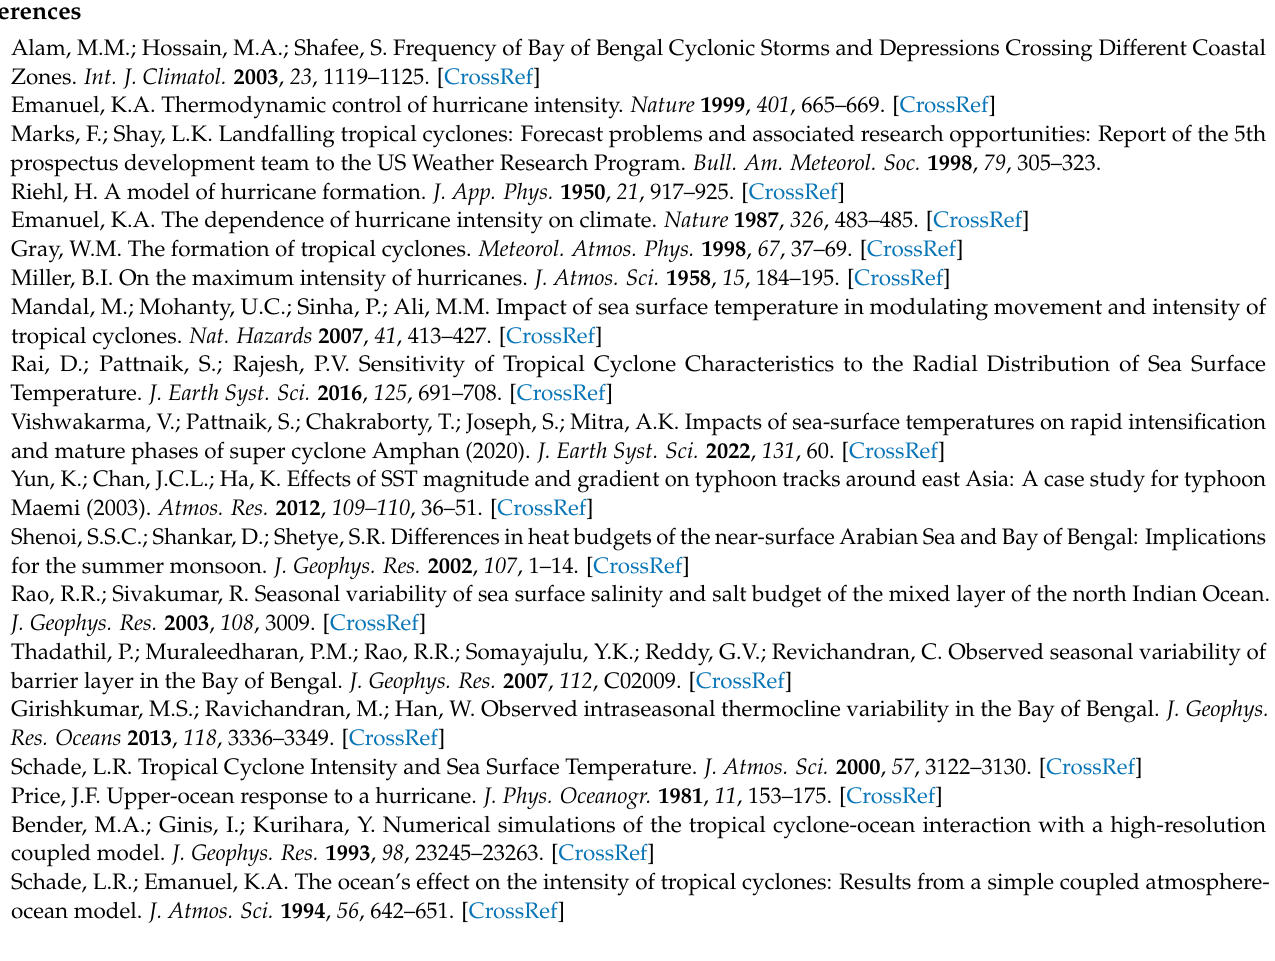
Figure S2: ETS and HSS of rainfall prediction for all the experiments for Day-1 (0–24 h), Day-2 (24–48 h), and Day-3 (48–72 h); Figure S3: Radial distribution of radar reflectivity (dbZ) as simulated in the three experiments at 12 h intervals from 24–60